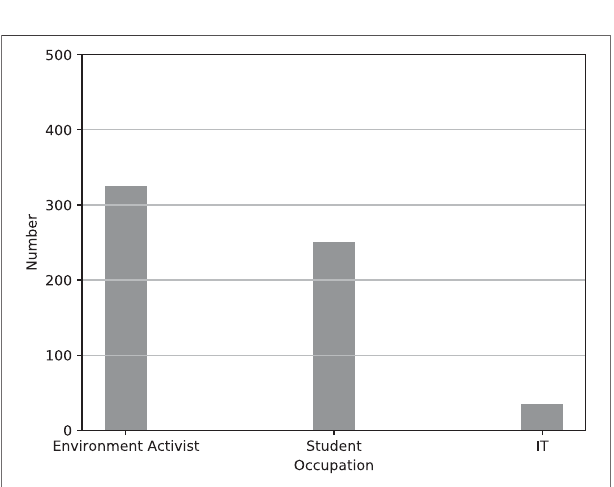
FIGURE7| Occupationfor Twitter users most negative towards the fi fth generation of cellular networks (5G).